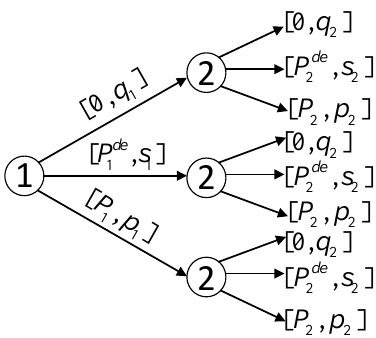
Figure 1. Three-state unfolding type formulation of unit loading.